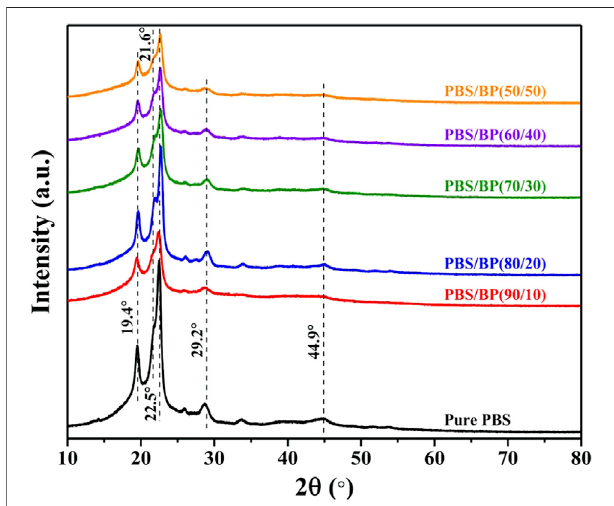
FIGURE 2 | XRD spectra of pure PBS and PBS/BP blends at varied